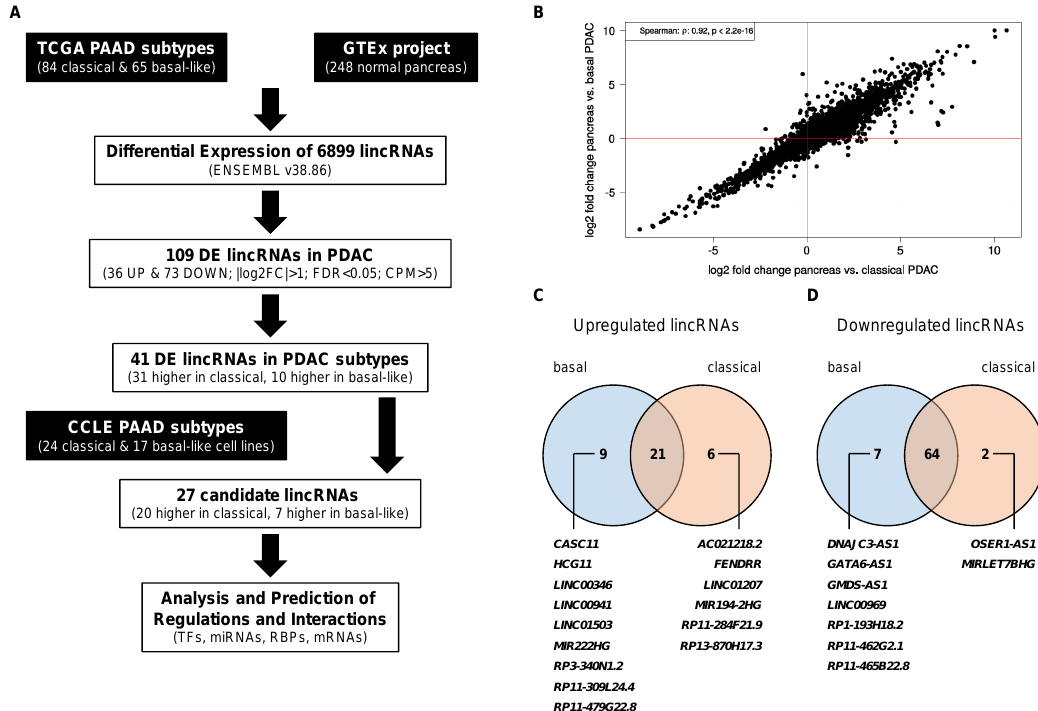
Figure 1. Analysis of lincRNA expression in PDAC (pancreatic ductal adenocarcinomas). ( A ) Flow-chart outlining the analysis pipeline to identify differentially expressed lincRNAs in pancreatic cancer using TCGA (The Cancer Genome Atlas) tumour samples; ( B ) log 2 fold changes of 6899 annotated lincRNAs in the comparison between normal pancreas tissue and classical PDAC (x-axis) and between pancreas tissue and PDAC samples categorized as basal-like subtype (y-axis). ( C ) Venn diagram depicting the overlap of lincRNAs upregulated in basal-like and classical tumour subtypes, respectively. ( D ) Venn diagram showing the overlap of lincRNAs downregulated in basal-like and classical PDAC subtypes. In total, 109 lincRNAs fulfilled the selection criteria ( | log 2 FC | > 1; False Discovery Rate (FDR) < 0.05; avg. Counts per million ( CPM ) > 5 in normal pancreas or the respective tumour subtype). PAAD: Pancreatic adenocarcinoma; GTEx: Genotype-Tissue Expression; CCLE: Cancer Cell Line Encyclopedia; TFs: Transcription factors; RBPs: RNA-binding